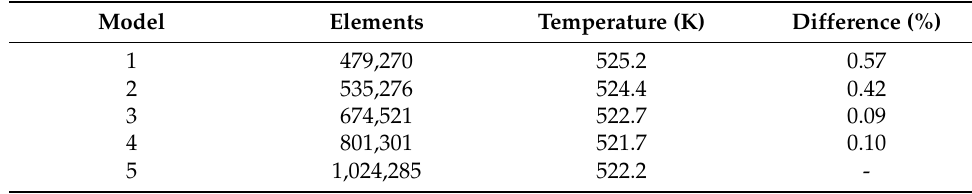
Table 2. Grid independency test for the fluid